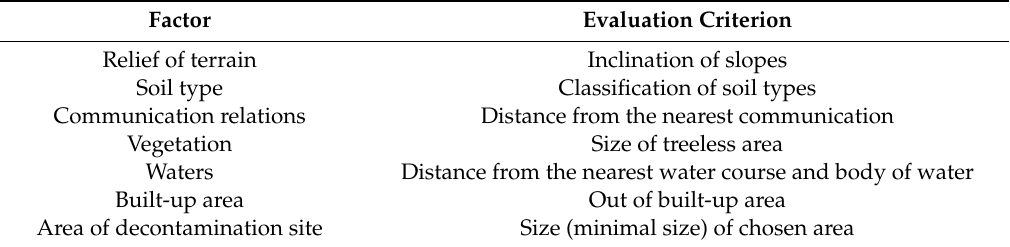
Table 1. Evaluation criteria for the choice of a suitable place for a decontamination site dislocation.